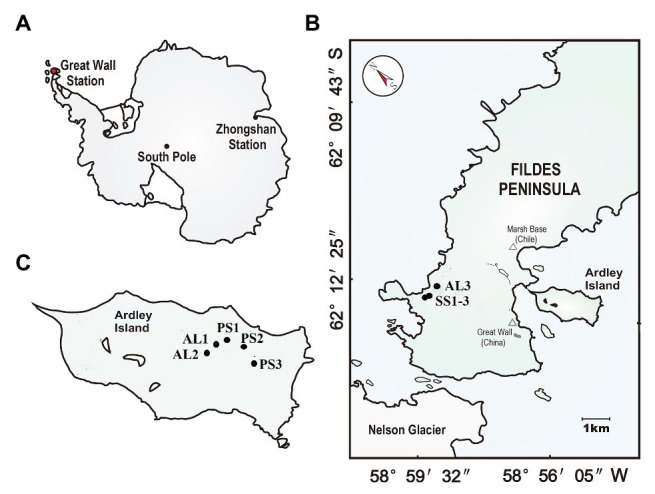
Soil sampling sites. (A): The red dot indicates the location of the study area in maritime Antarctica; (B): the location of the sampling sites on the Fildes Peninsula. The tundra soils included seal colony soils SS (SS1–SS3) in the western coast of the Fildes Peninsula and adjacent seal-lacking tundra soil AL3; (C): the location of the sampling sites on Ardley Island. The tundra soils included the eastern active penguin colony tundra soils PS (PS1–PS3) and the adjacent penguin-lacking tundra soils AL1 and AL2.